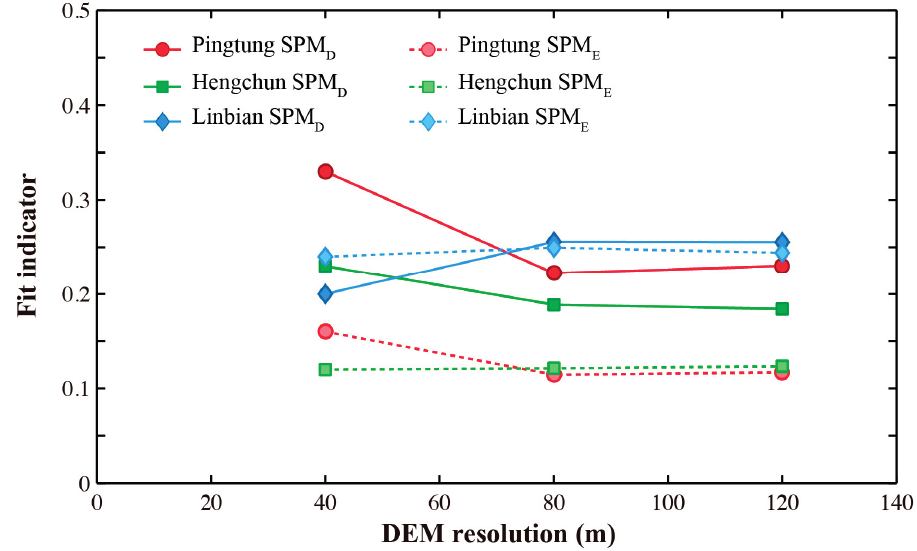
Figure 12. Comparison of the model performance between SPM D and SPM E using the performance indicator for various DEM